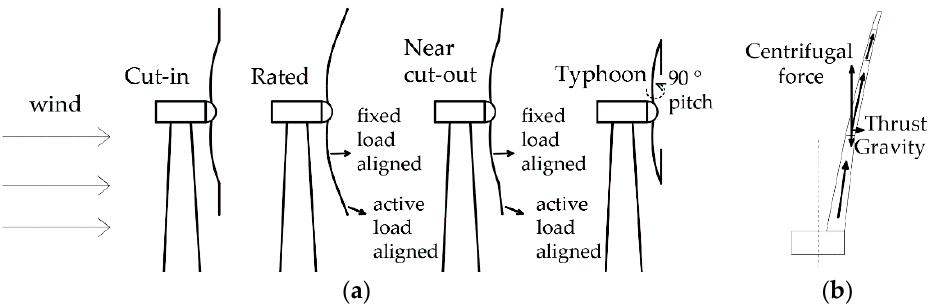
Figure 1. New concept of a combination of a fixed and an active load-alignment: ( a ) blade shape under different wind conditions; ( b ) sketch of